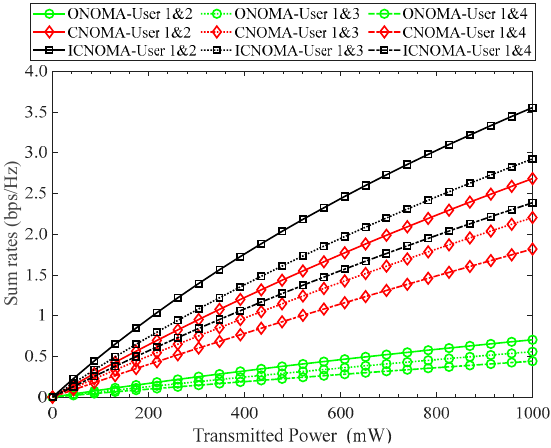
Figure 6. Sum rates versus transmitted power of NOMA-based UOWC system.